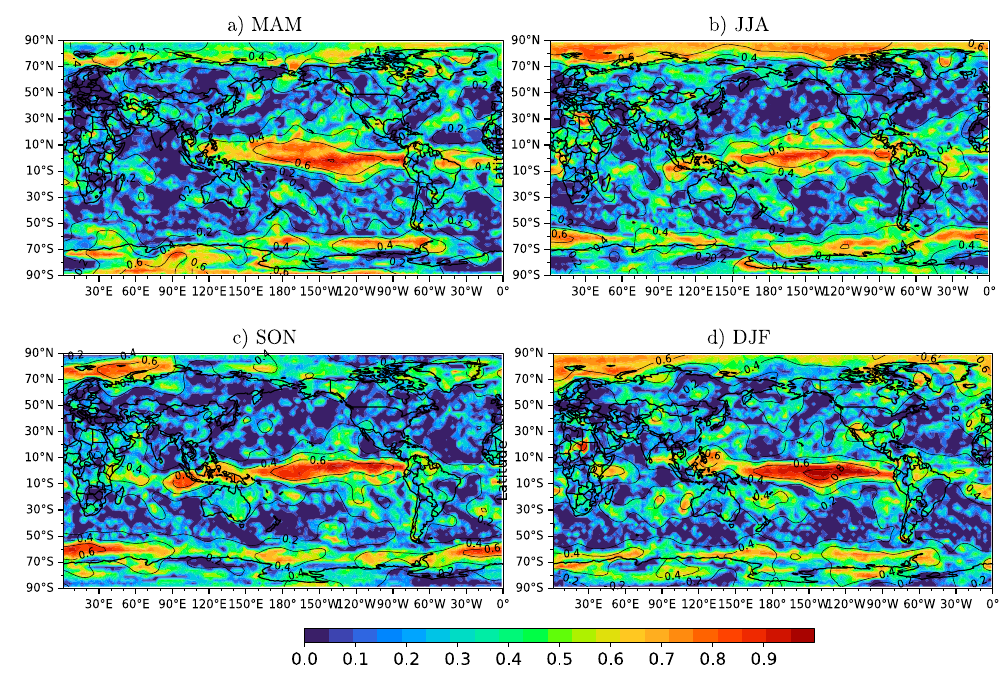
Figure 5. Seasonal potential predictability of GPCP precipitation.